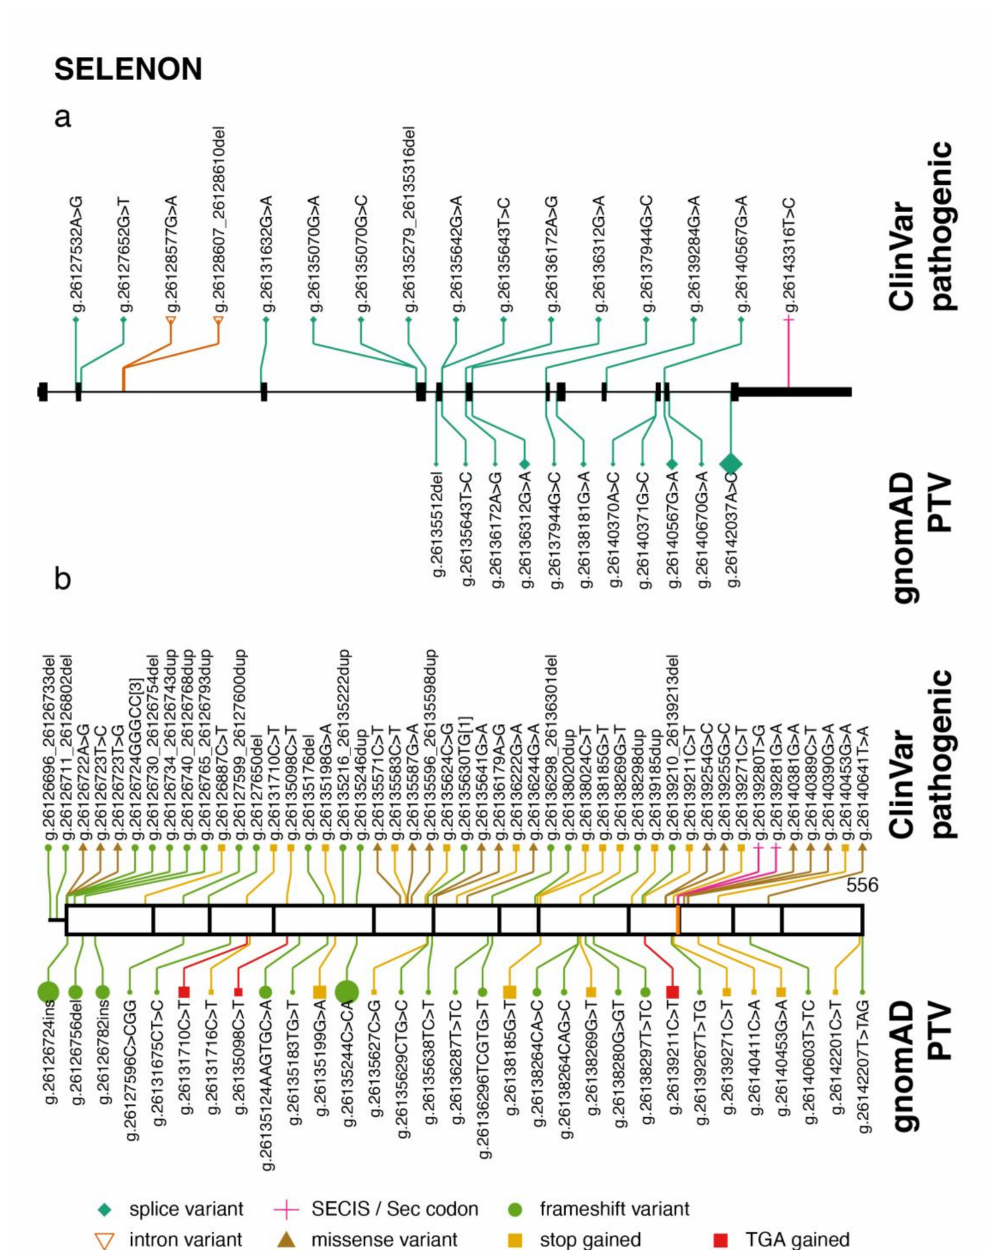
Figure 1. Pathogenic variants and protein-truncating variants in SELENON. ( a ) Genomic organization of SELENON exons, and location of ClinVar pathogenic variants (above) and gnomAD protein- truncating variants (PTV) (below). The shape and color of each variant corresponds to its predicted consequence (see legend). For gnomAD variants only, the size of the symbol is proportional to the allele frequency. The genomic notation is used to describe each variant. ( b ) Location of variants along the SELENON protein sequence. The length of the protein is indicated on the right. Vertical black lines correspond to exon boundaries, and the vertical orange line correspond to the Sec residue. The same aesthetics for variants as ( a ) are used. The genomic coordinates correspond to genome build GRCh37/hg19; the SELENON gene structure and protein sequence correspond to transcript